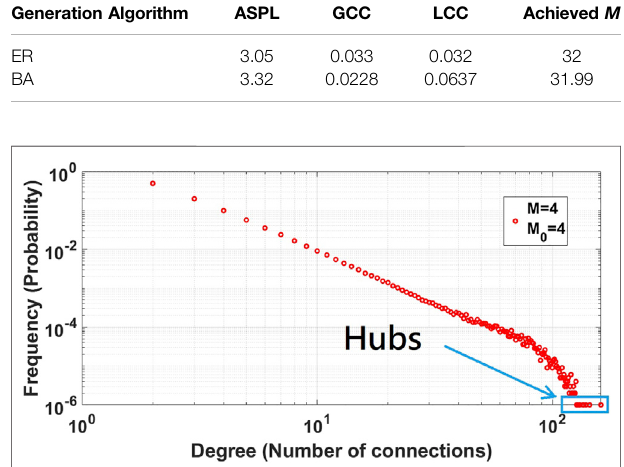
FIGURE8| ConceptofdisseminationwavesintheBitcoinnetwork. n 0 is the miner of the block and W 1 , W 2 , and W 3 are the fi rst, second, and third dissemination waves.